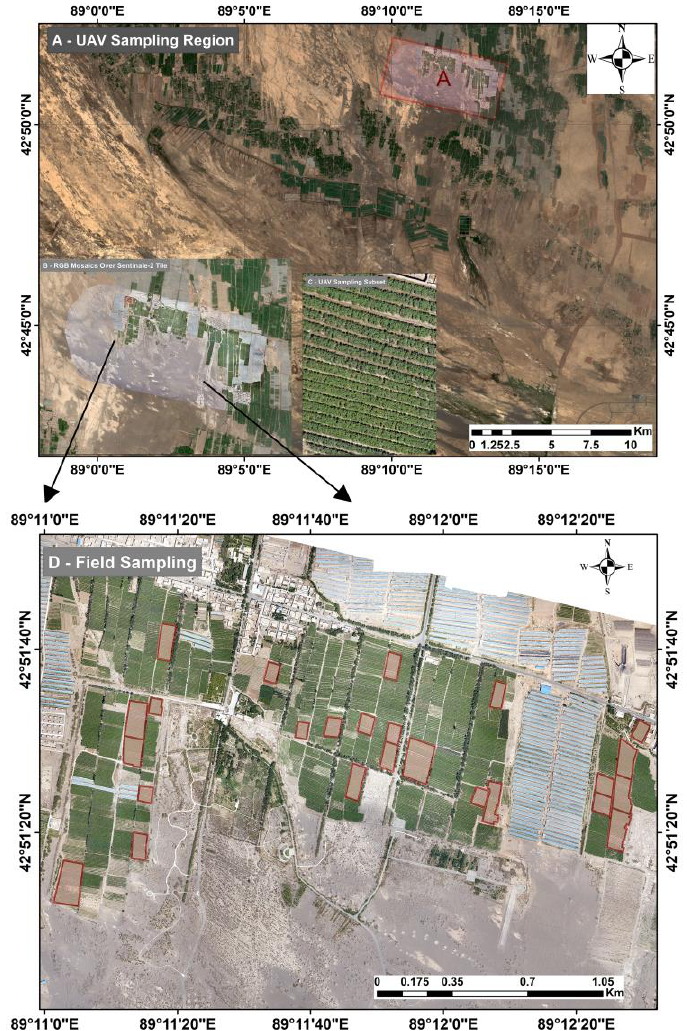
Figure 1. The top image area A covered by a light red mask shows the unmanned aerial vehicle (UAV) sampling region in Gaochang zone of Turpan, and area B shows RGB mosaics over a Sentinel-2A tile, and C is a 6-cm spatial resolution image acquired on 16 May 2019. Multispectral images were acquired on the same day and covered the same area. The bottom image area covered by a light red mask shows the locations of the observed field plots.